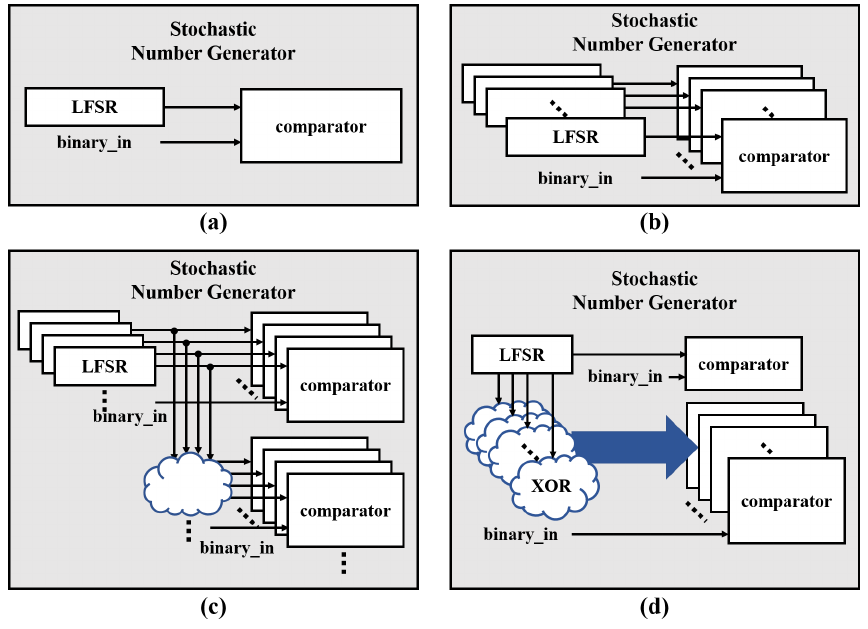
Figure 9. Three different types of parallel LFSRs: ( a ) Basic LFSRs ( b ) Multiple LFSRs ( c ) Shared LFSRs ( d ) Parallel